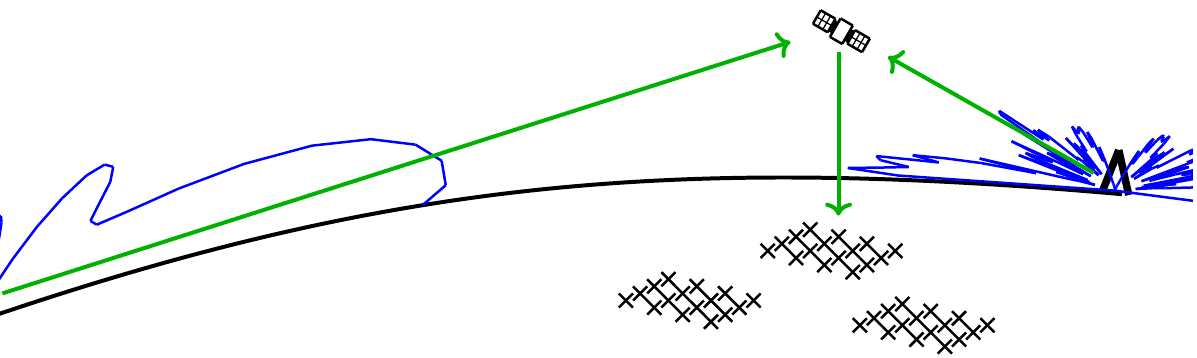
Figure 1. Illustration of the use of the Murchison Widefield Array (MWA) as a passive radar, showing two transmitters, one satellite and three MWA tiles. The two transmitters’ elevation beampatterns (in blue) and the signal path (in green) are also